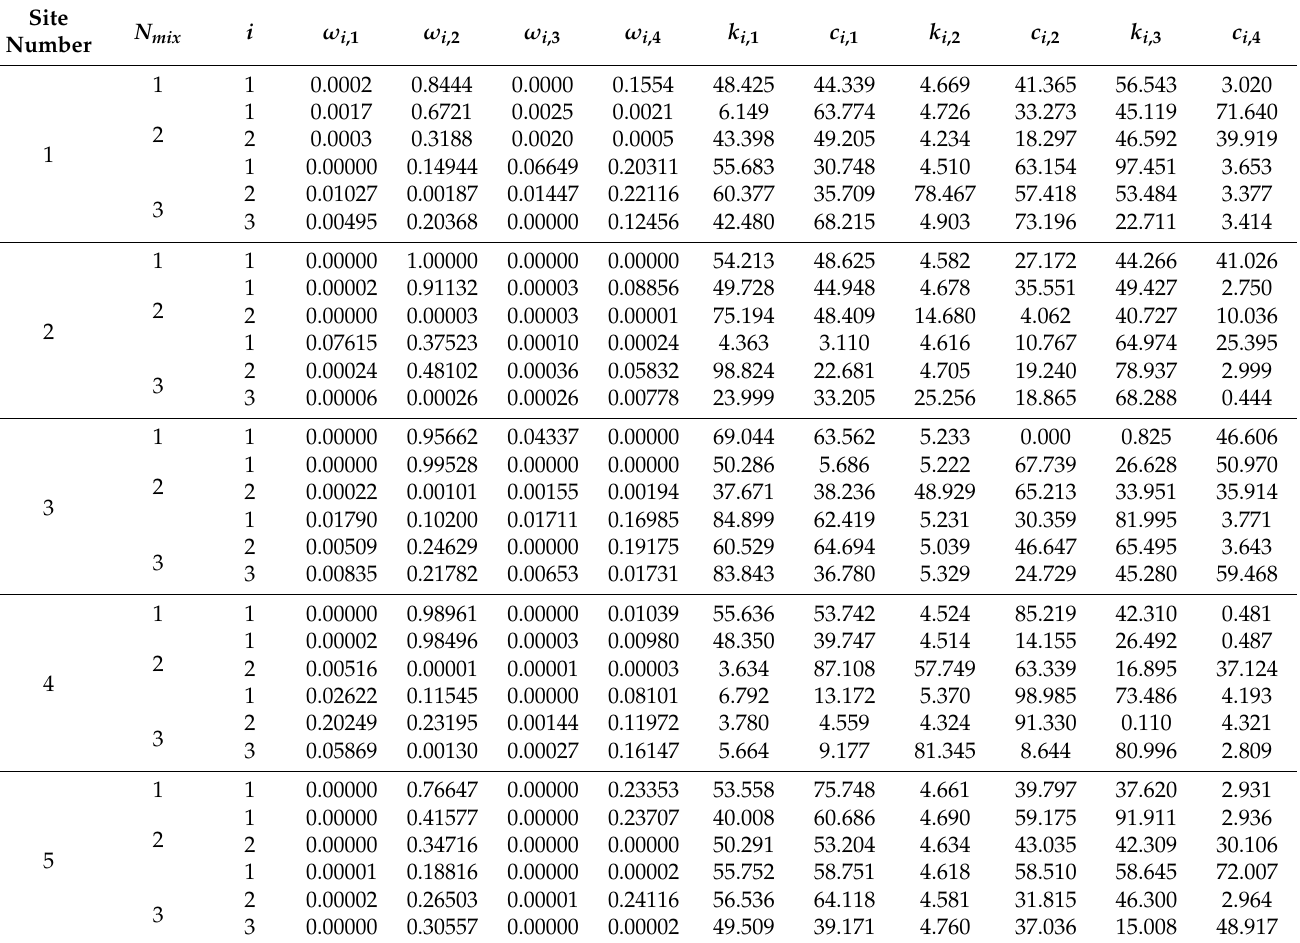
Table 8. Weights and PDFs parameters of f mix for variable wind speed spacings using the NSGA- II